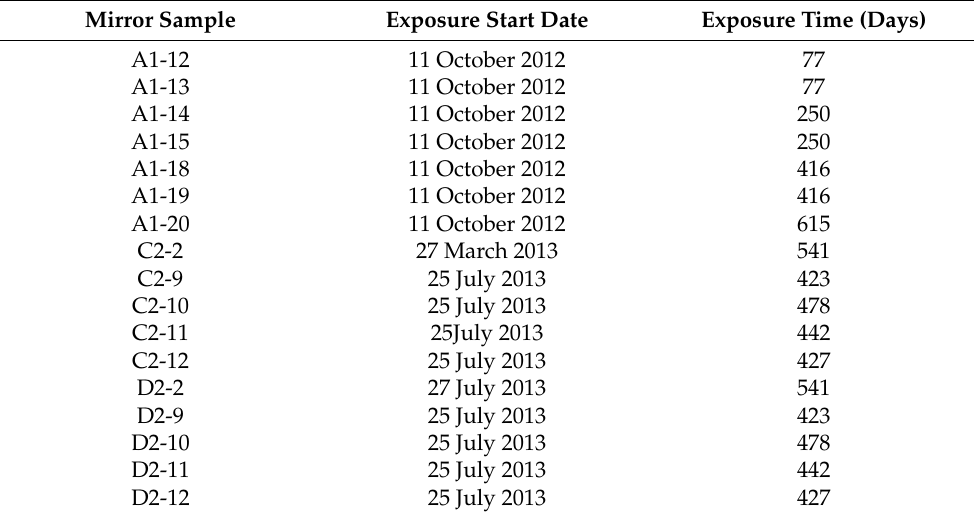
Table 3. Exposure start date and exposure time for mirrors tested at the seaside site. Mirror Sample